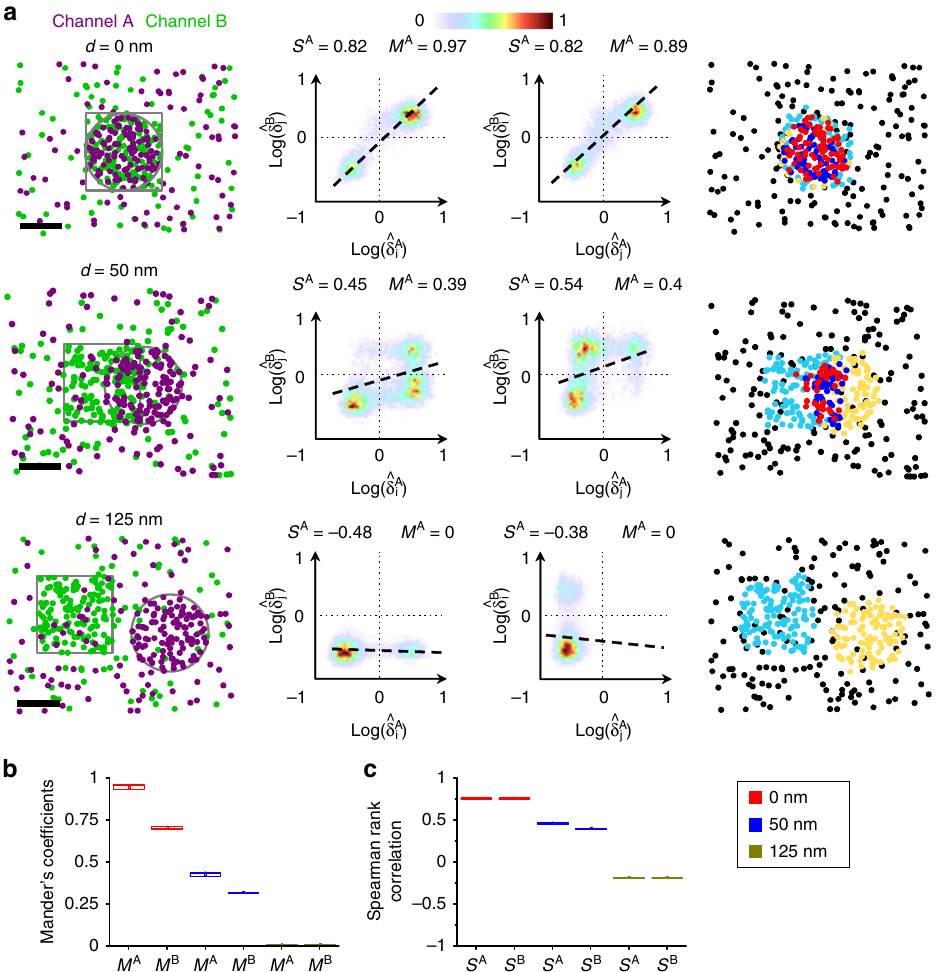
Fig. 2 Voronoï-based colocalization analysis of 2-color simulation data. a 2-color 100 nm circular (purple) and square (green) clusters with inter-cluster distances of 0, 50 and 125 nm (scale bar 50 nm). Original 2-color localizations (left). Scatterplots of the normalized pairs densities for the 2 channels (middle). Scatterplots are de fi ned for each channel, always keeping the density of channel A in abscises and the density of channel B in ordinates. The dashed line is a visual representation of the Spearman rank correlation analysis while the solid line shows the threshold used to compute the Manders coef fi cients. 5 class classi fi cation of the 2-color localizations computed from the overlapping Voronoï diagrams (right). b Manders ’ coef fi cients and ( c ) Spearman rank correlation computed on the 3 colocalization conditions for different density ratios ranging from 1:1 (0.013 mol.nm − 2 , 0.013 mol.nm -2 ) to 1:5 (0.013 mol.nm -2 , 0.065 mol.nm -2 ). All 3 colocalization conditions were correctly retrieved for all the densities: ( d = 0 nm, M A = 0.94 ± 0.006 SEM, M B = 0.7 ± 0.004 SEM; d = 50 nm, M A = 0.43 ± 0.004 SEM, M B = 0.32 ± 0.001 SEM; d = 125 nm, M A = 0.01 ± 0.001 SEM, M B = 0.01 ± 0.0001 SEM) for Manders and ( d = 0 nm, S A = 0.76± 0.003 SEM, S B = 0.76 ± 0.005 SEM; d = 50 nm, S A = 0.46 ± 0.005 SEM, S B = 0.4 ± 0.003 SEM; d = 125 nm, S A =